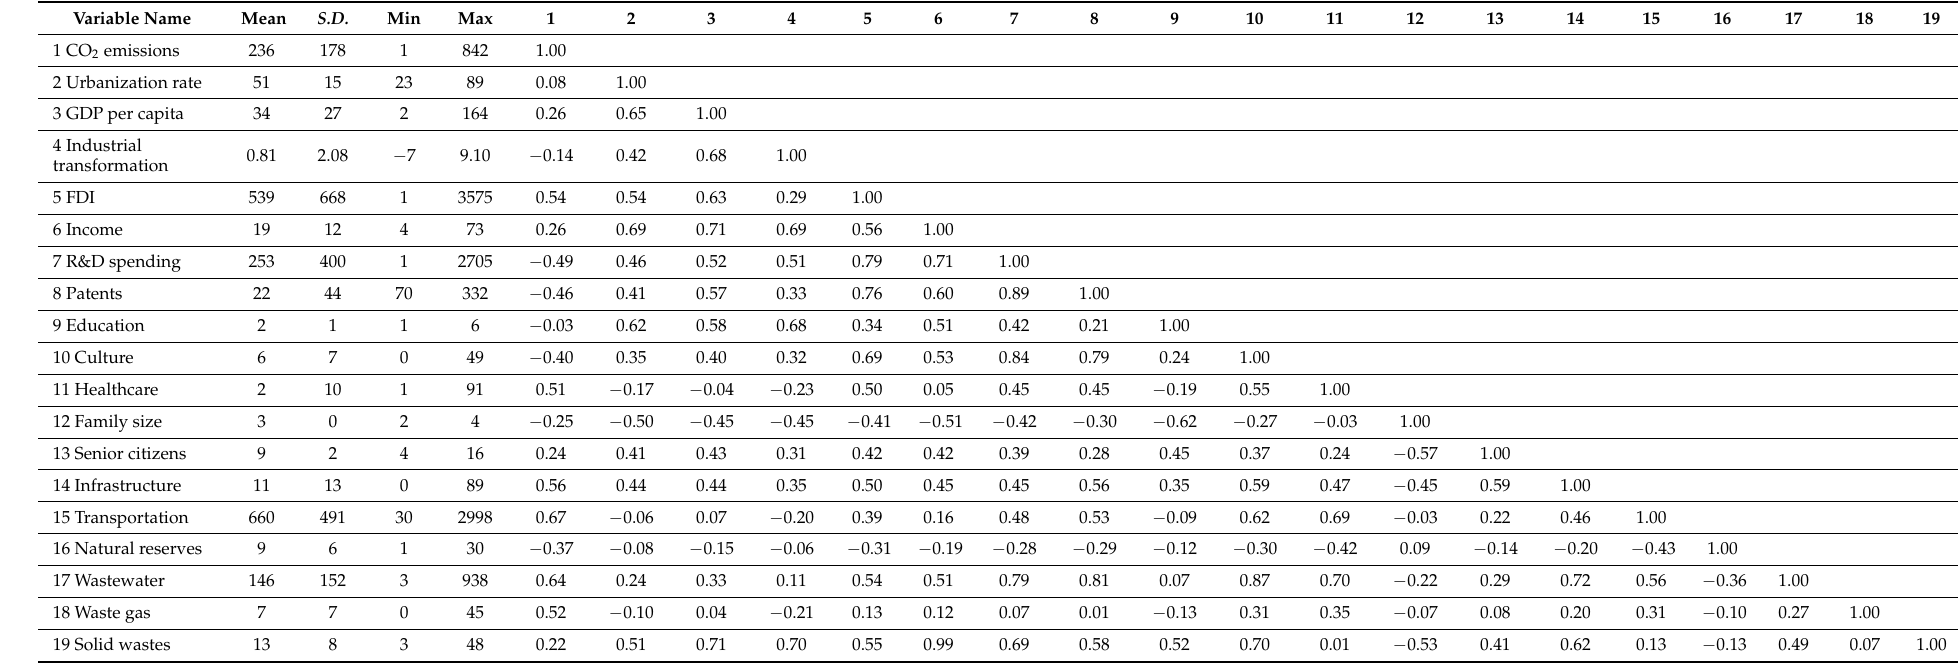
Table 2. Descriptive statistics and